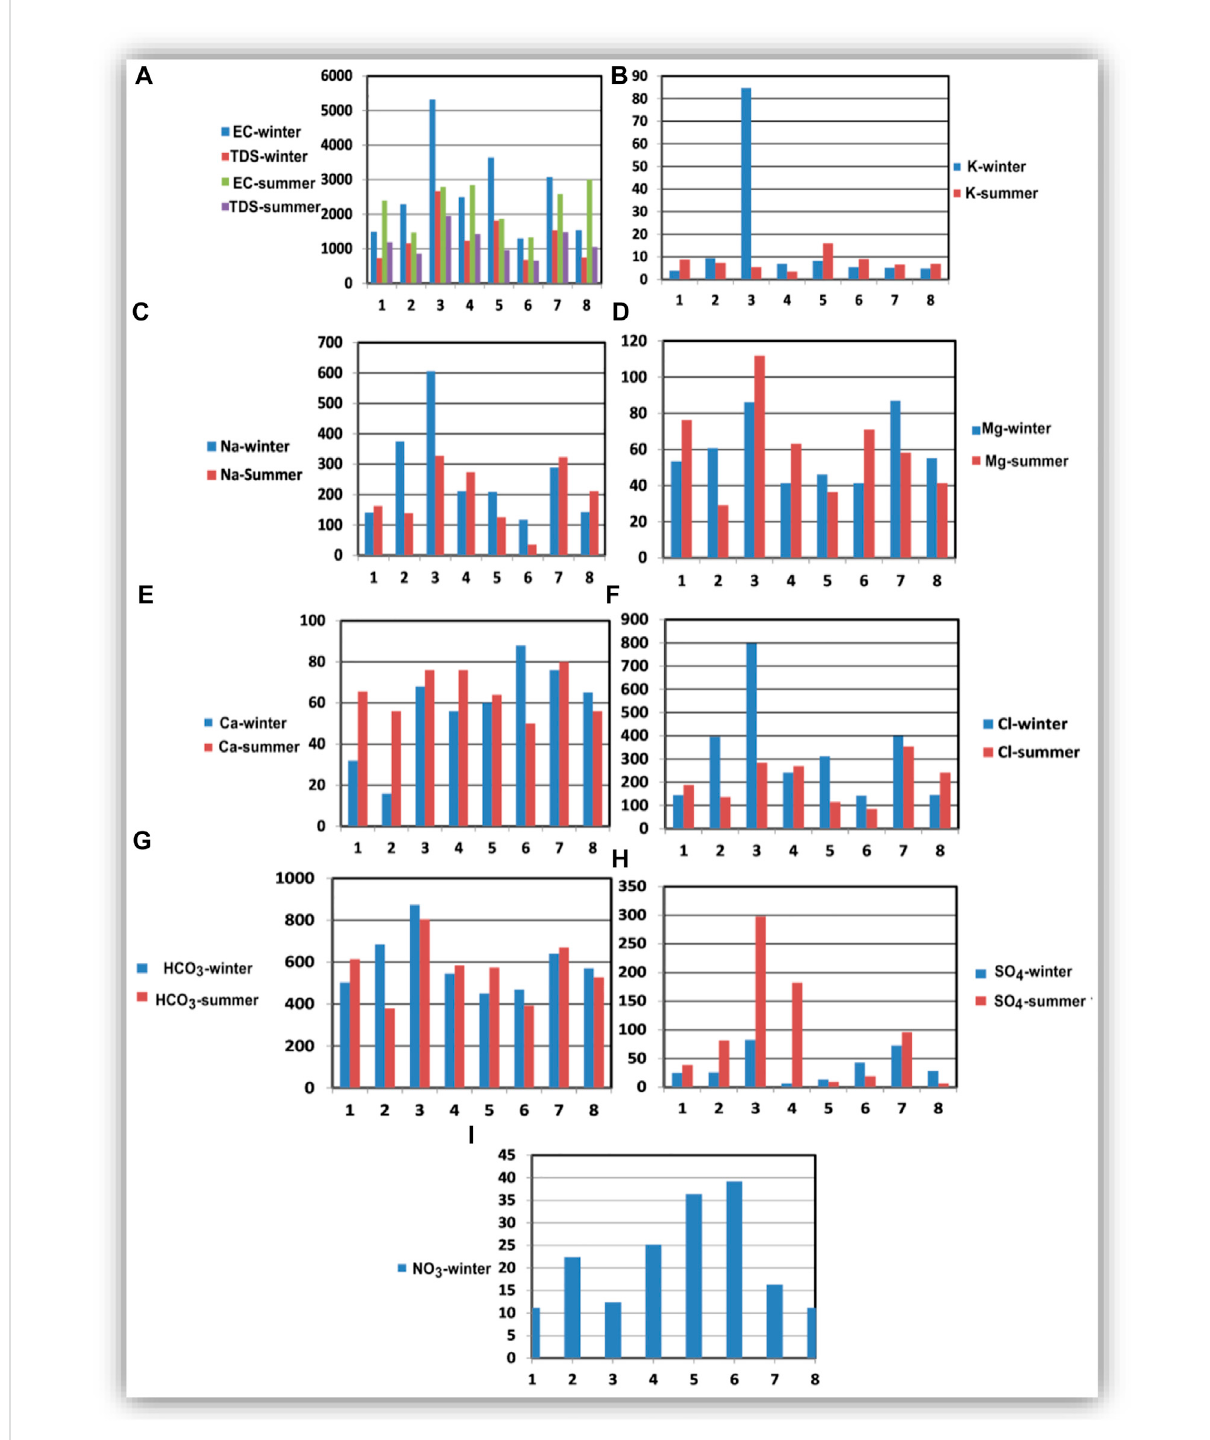
FIGURE 5 The hydrochemical composition of the collected soil water samples during winter and summer